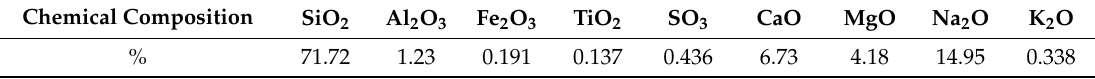
Table 1. Chemical composition of standard glass.